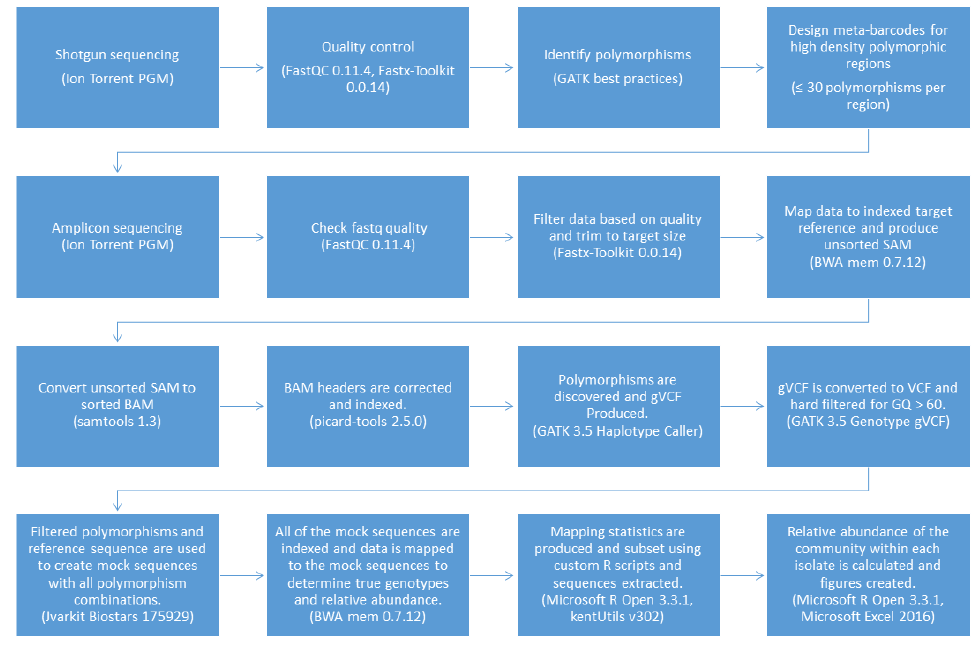
Figure 2. The MetaGaAP workflow to identify genotypes and the relative abundance of the community composition within a single isolate.